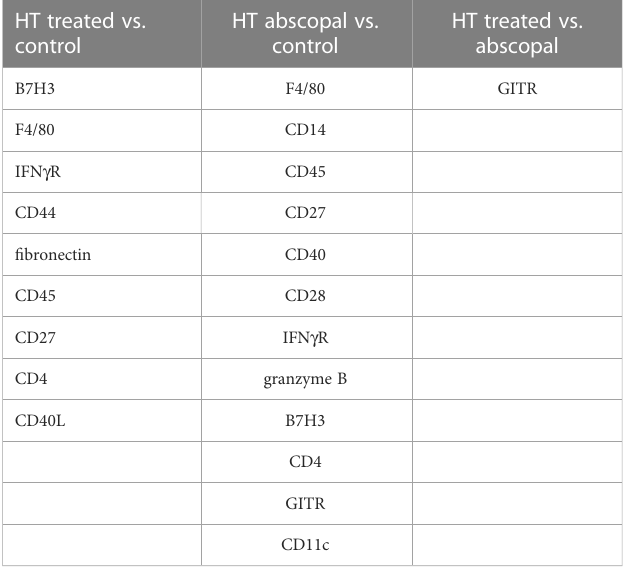
TABLE 1 Differential expression of immune-relevant proteins between control, histotripsy-treated, and histotripsy-abscopal tumors on day 7. HT treated vs.